Question: Describe this figure in one sentence.
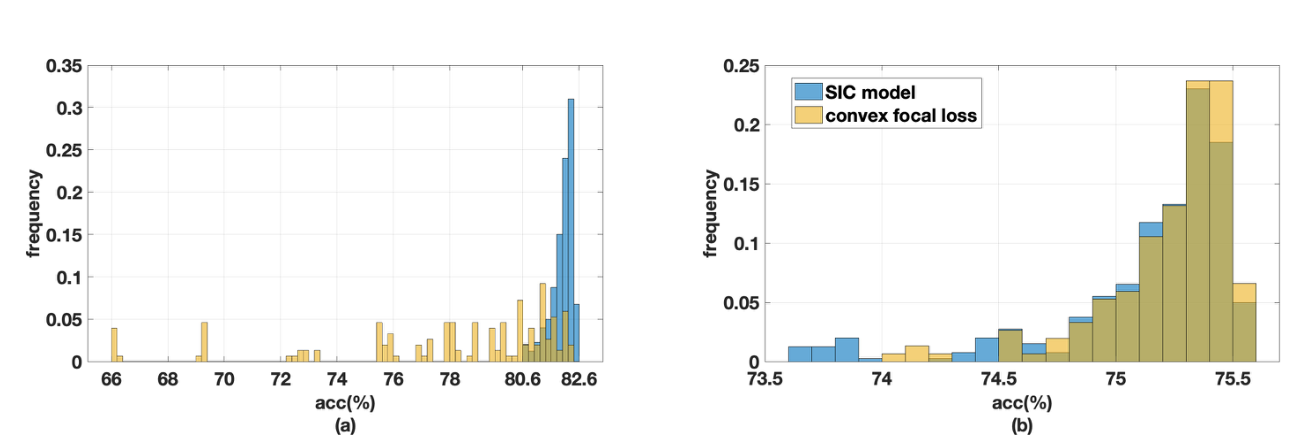
Answer: The statistical distributions of 20 × 20 SIC models and 19 × 8 convex focal losses with respect to test classification accuracy. (a) The two-class histogram. The SIC models are in the [80.64%, 82.51%] range, and convex focal losses are in the [65.93%, 82.37%] range. The SIC model is less sensitive to internal parameters α± and outperforms the π-weighted convex focal losses. (b) The multi-class histogram. The SIC models are in the [73.64%, 75.57%] range, and convex focal losses are in the [74.08%, 75.55%] range. Although the SIC models have no external π-weight parameters, they show comparable performance to π-weighted convex focal loss. For more information on the matrix pattern of the models, refer to Figure 7.